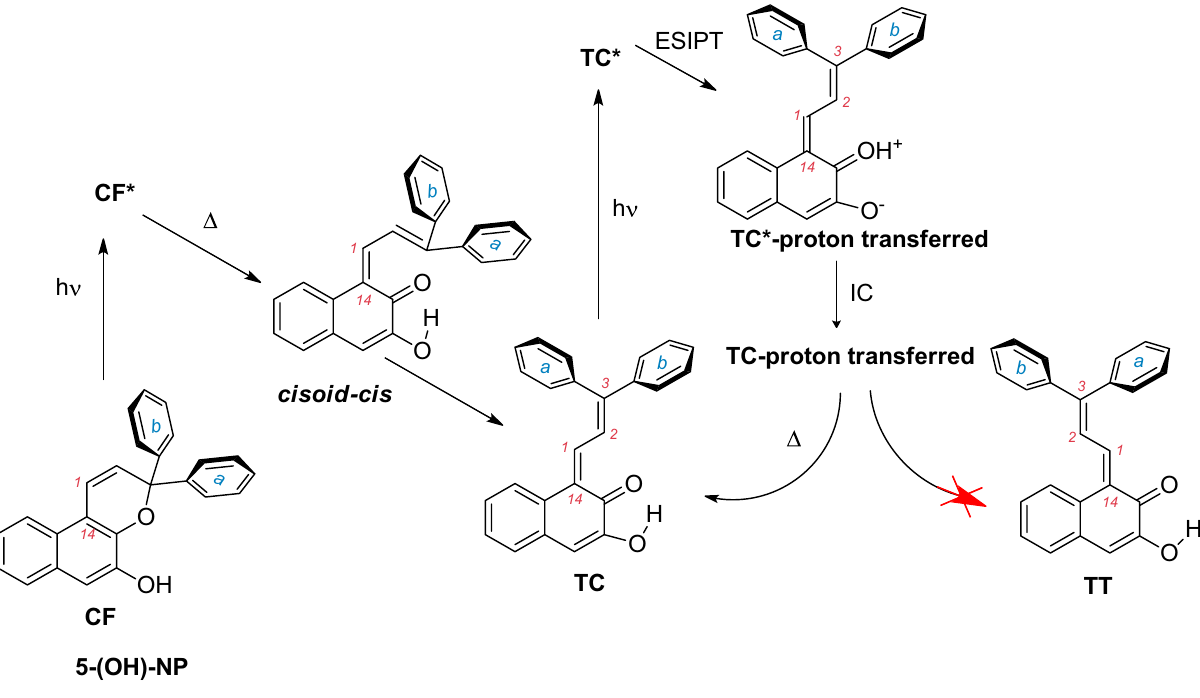
Figure 1. Expected photostabilization of the TC form due to the ESIPT